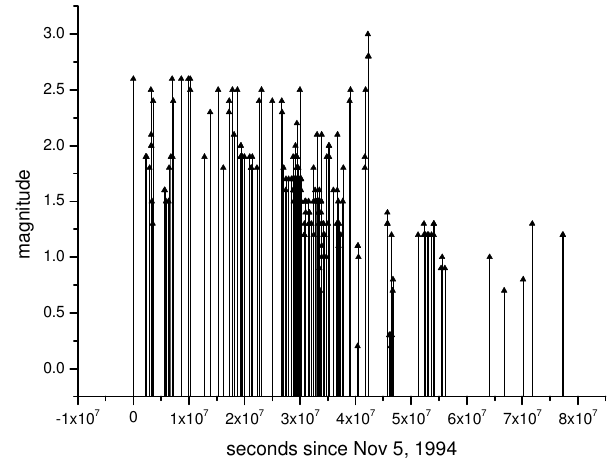
Fig. 3. Cumulative number of events N(t) vs. time of occurrence for cluster a.